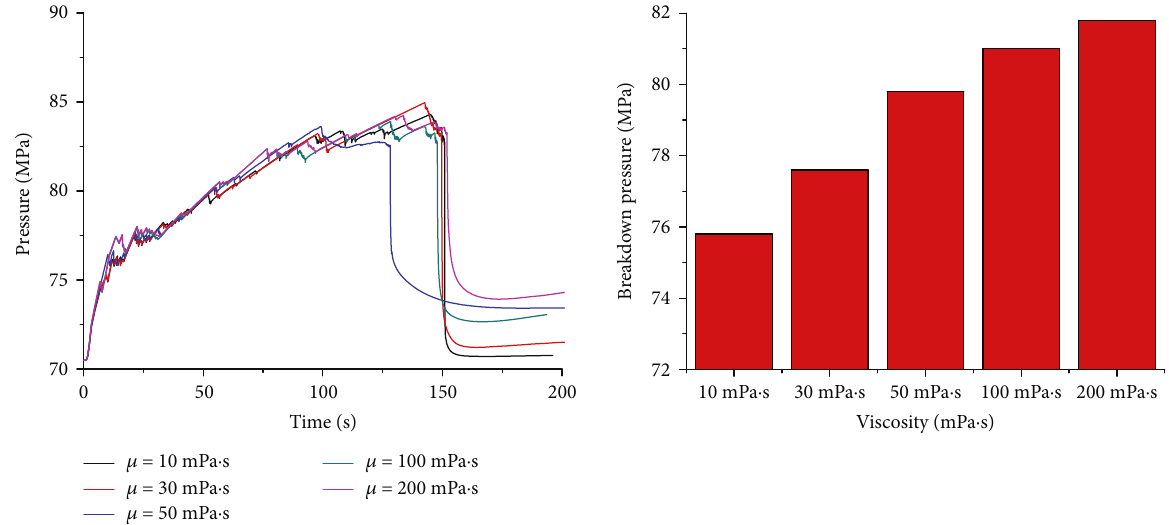
Figure 44: Injection pressure and fracture pressure at the NF approaching angle of 60 ° and under the acid viscosity of 10-200mPa · (Figure 23). When t = 3 : 9 s , the HF is diverted upward before intersecting NF1. When t = 7 : 2 s , the HF intersects with NF1 and propagates upward along the right side of NF1. When t = 15 : 1 s , the HF is diverted toward NF2. When t = 20 : 1 s , the HF is diverted downward and bypasses NF2. When t = 26 : 7 s , the HF is diverted toward NF3. When t = 37 : 1 s , the HF bypasses NF3.